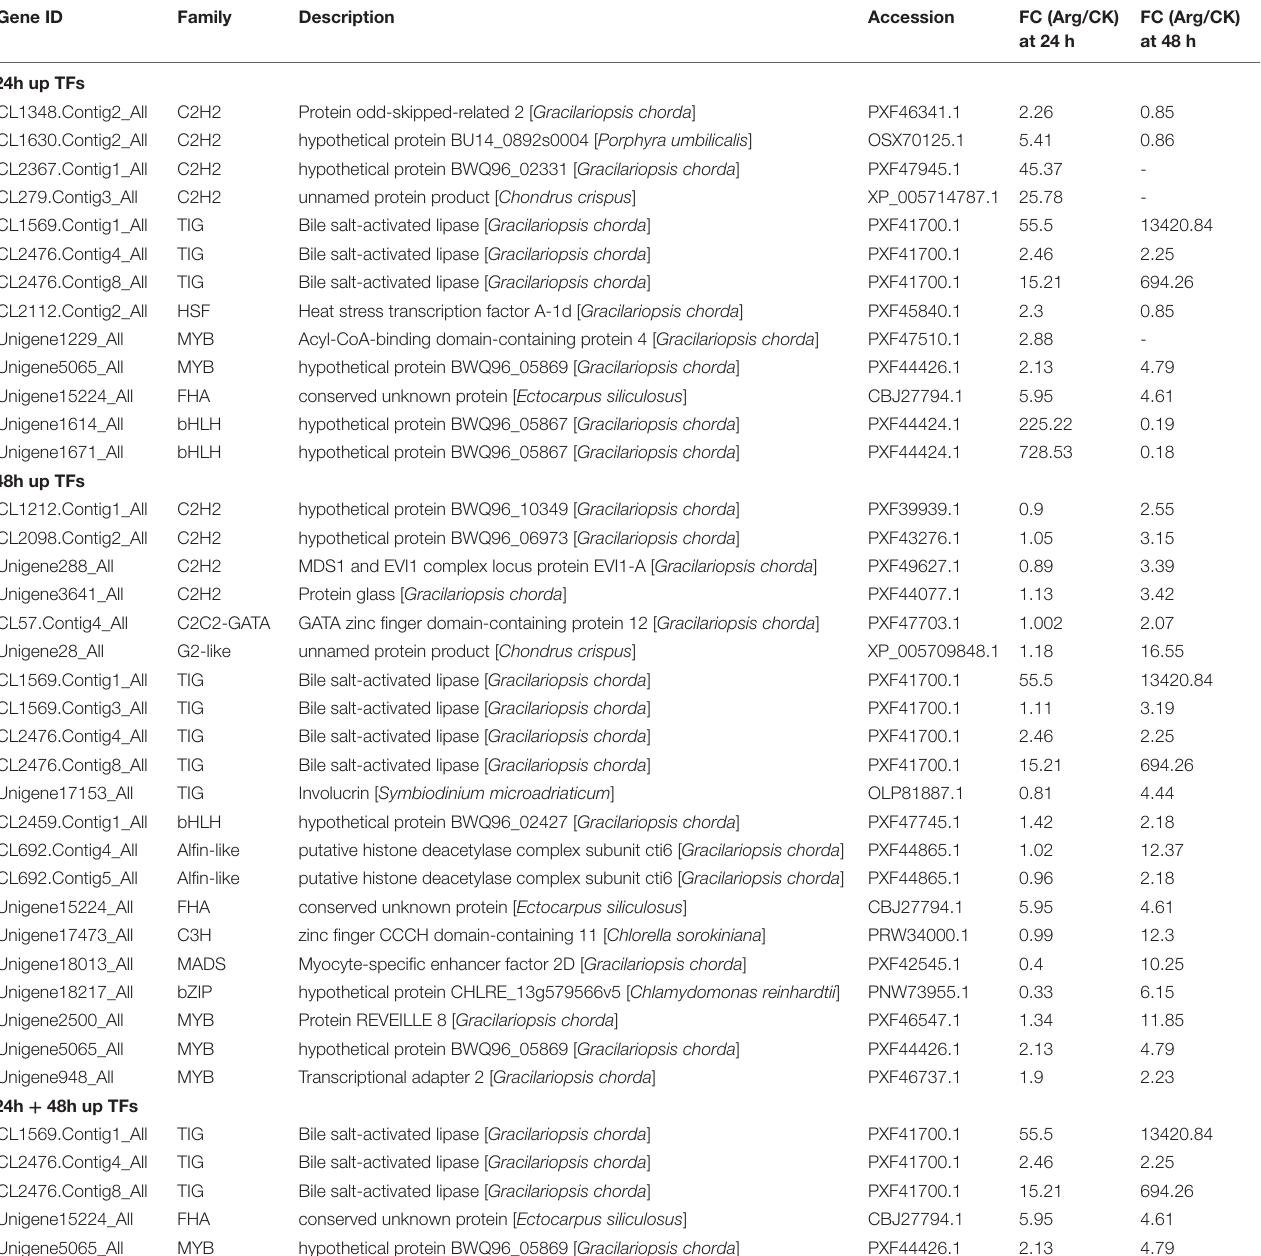
TABLE 2 | The DEGs encoding